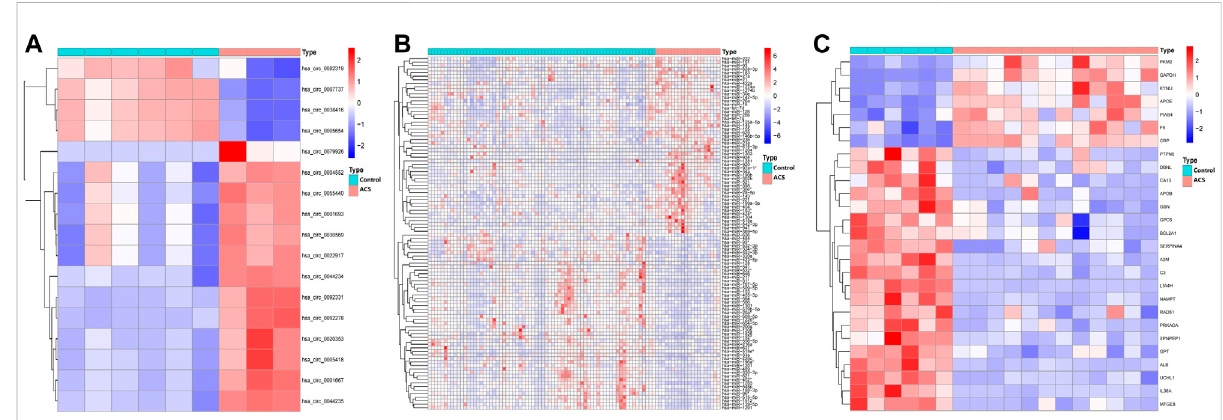
FIGURE 2 Heatmap of differentially expressed circRNA, miRNA, and mRNA. Red represents upregulated expression, and blue means downregulated expression. (A) 17 differentially expressed circRNAs in the GSE197137 dataset. (B) Top 50 of 229 differentially expressed miRNAs in the